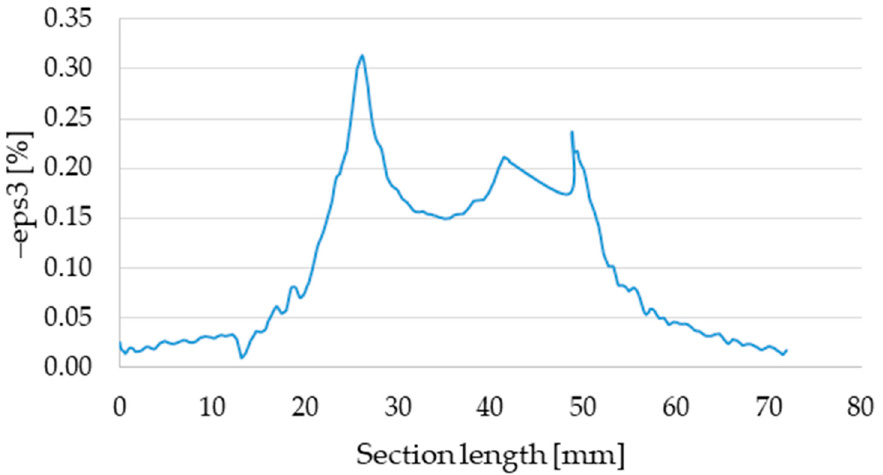
Figure 4. Al99 sample plate with P9/SC9 painting and cleaning process (dimensions are in mm).